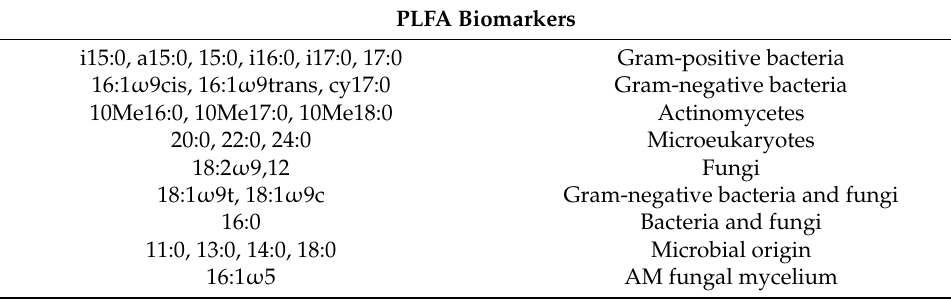
Table 2. The phospholipid fatty acids methyl ester biomarkers found in our